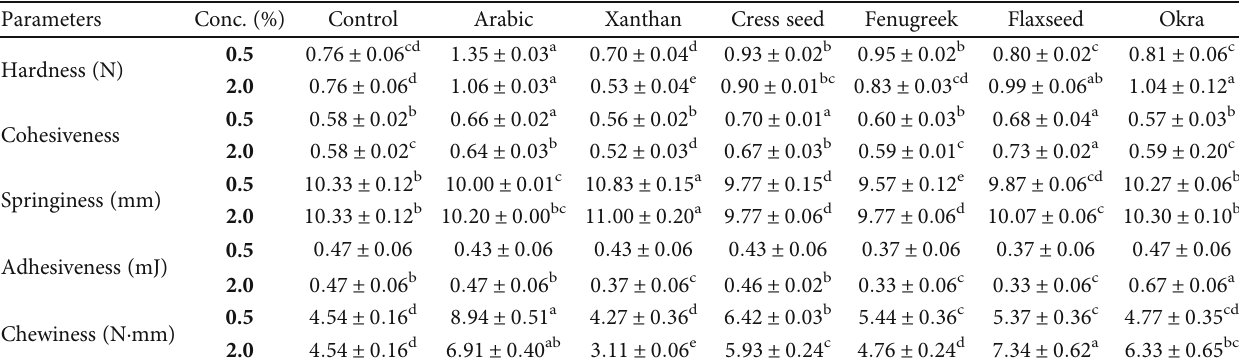
Table 4: E ff ect of gums on the TPA of sweet potato starch. Parameters Conc. (%) Control